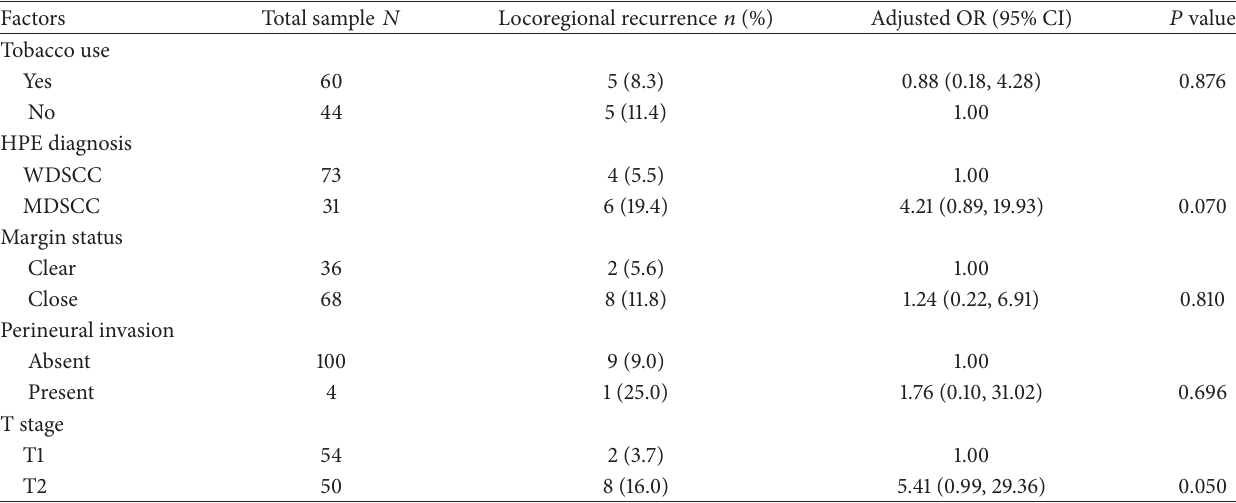
Table 5: Multivariate logistic regression model in predicting the recurrence in the sample with close and clear margin status.